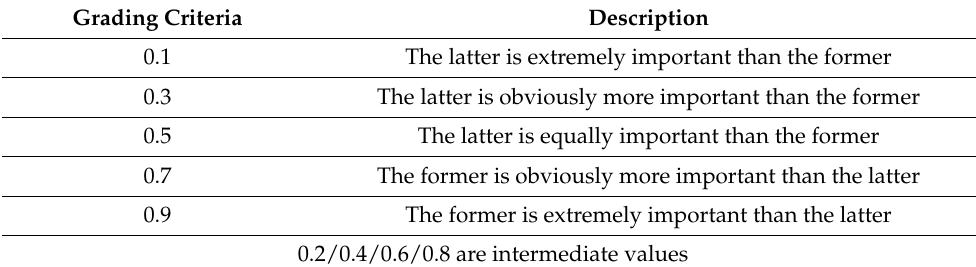
Table A2. The design of evaluation indicators and